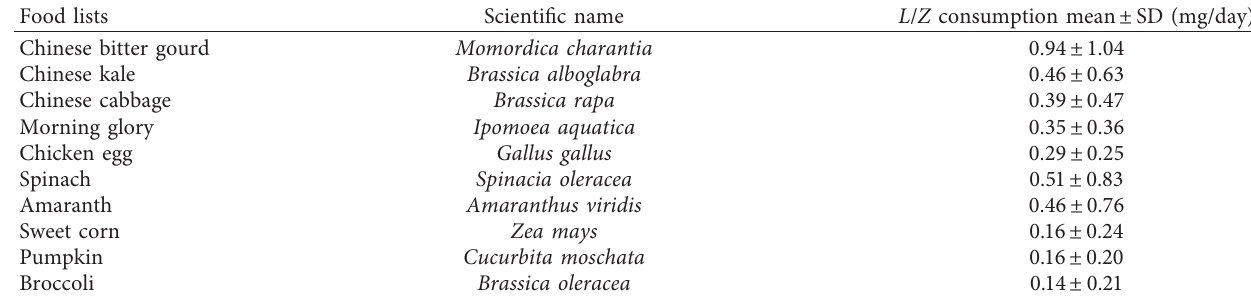
Table 2: Daily intake of L / Z ∗ of the top ten foods.